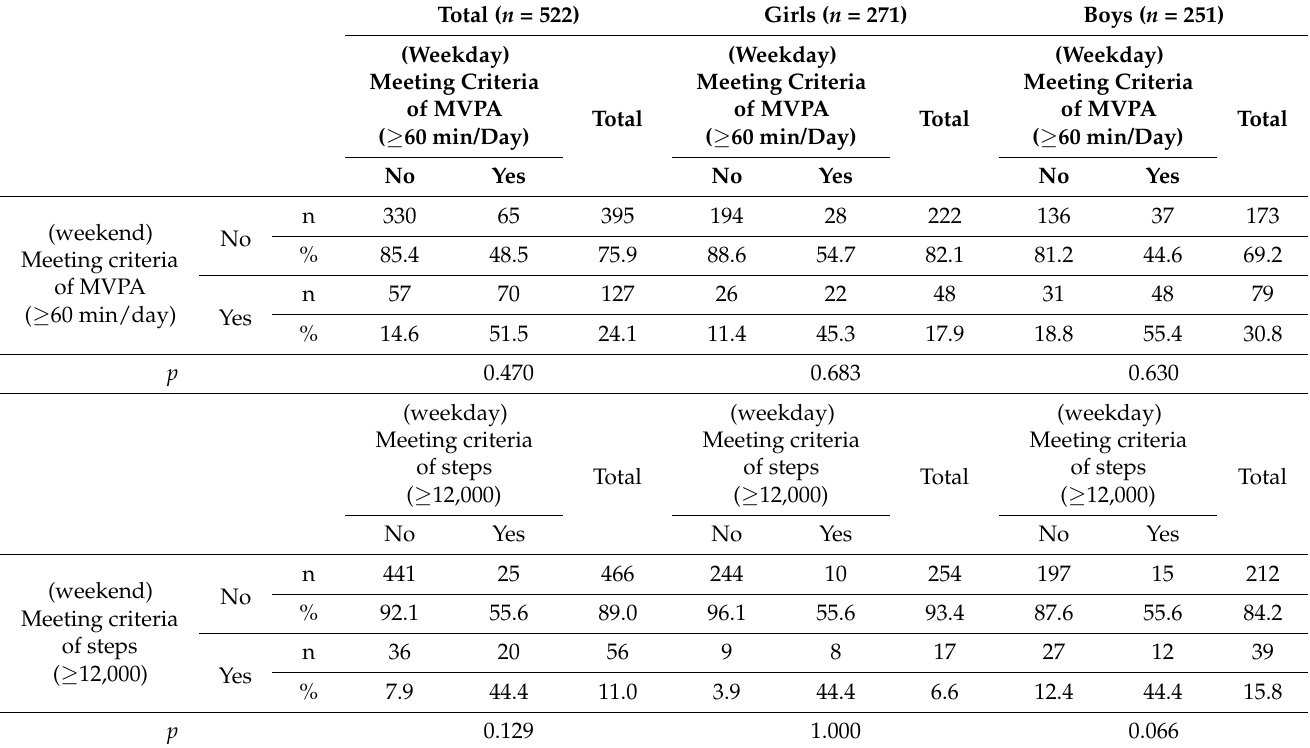
Table 4. Meeting physical activity criteria at weekends vs.